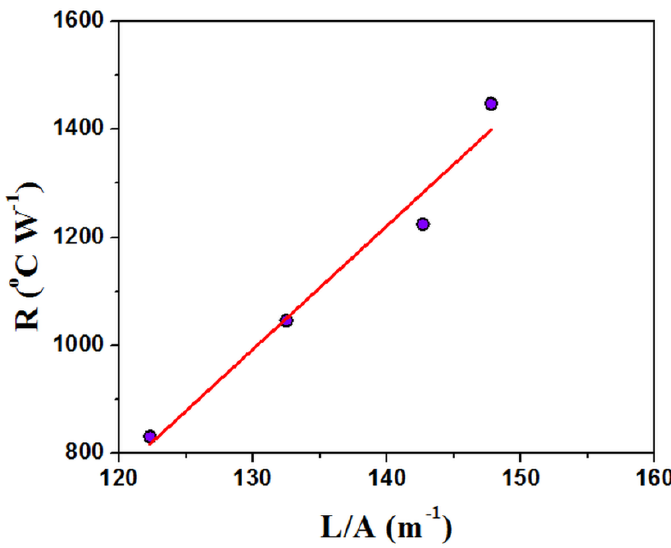
Figure 11. Plot of the thermal resistance, R, as a function of the ratio of the length, L, and section, S of the sample PVP_SiO 2 HT.